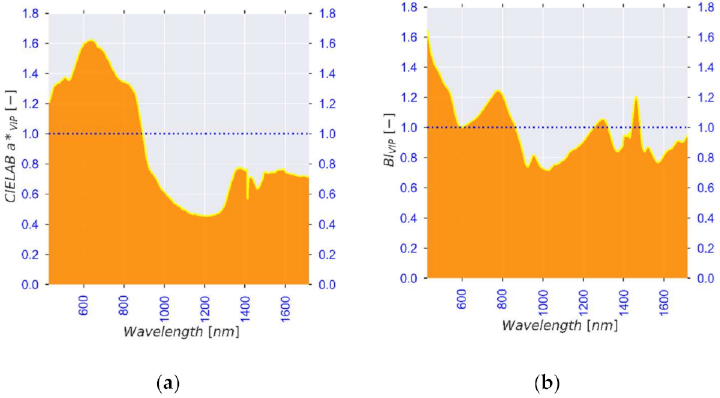
Figure 7. VIP plots for ( a ) CIELAB a* and ( b ) Browning Index. Figure 8a,b present the VIP scores of the total flavonoid content and total antioxidant activity, respectively. The informative waveband for TFC is at 903 nm in the third overtone zone of C-H. Smaller peaks in the VIP plot were observed at 1407–1600 nm in the first overtone combination zone for C-H. These regions have been associated with phenolic compounds [113–115]. Phenolic compounds combined with the vitamins in cocoyam tubers contribute to its high antioxidant activity [106,112]. The peaks in the TFC VIP plot also appear in the TAA VIP plot at similar wavebands as shown in Figure 8a,b. However, the TAA VIP plot has additional peaks at 522, 558, 802, 884, 1273, 1360, 1412, 1465 and 1600 nm. These peaks could be related to other bioactive compounds not quantified in this study.